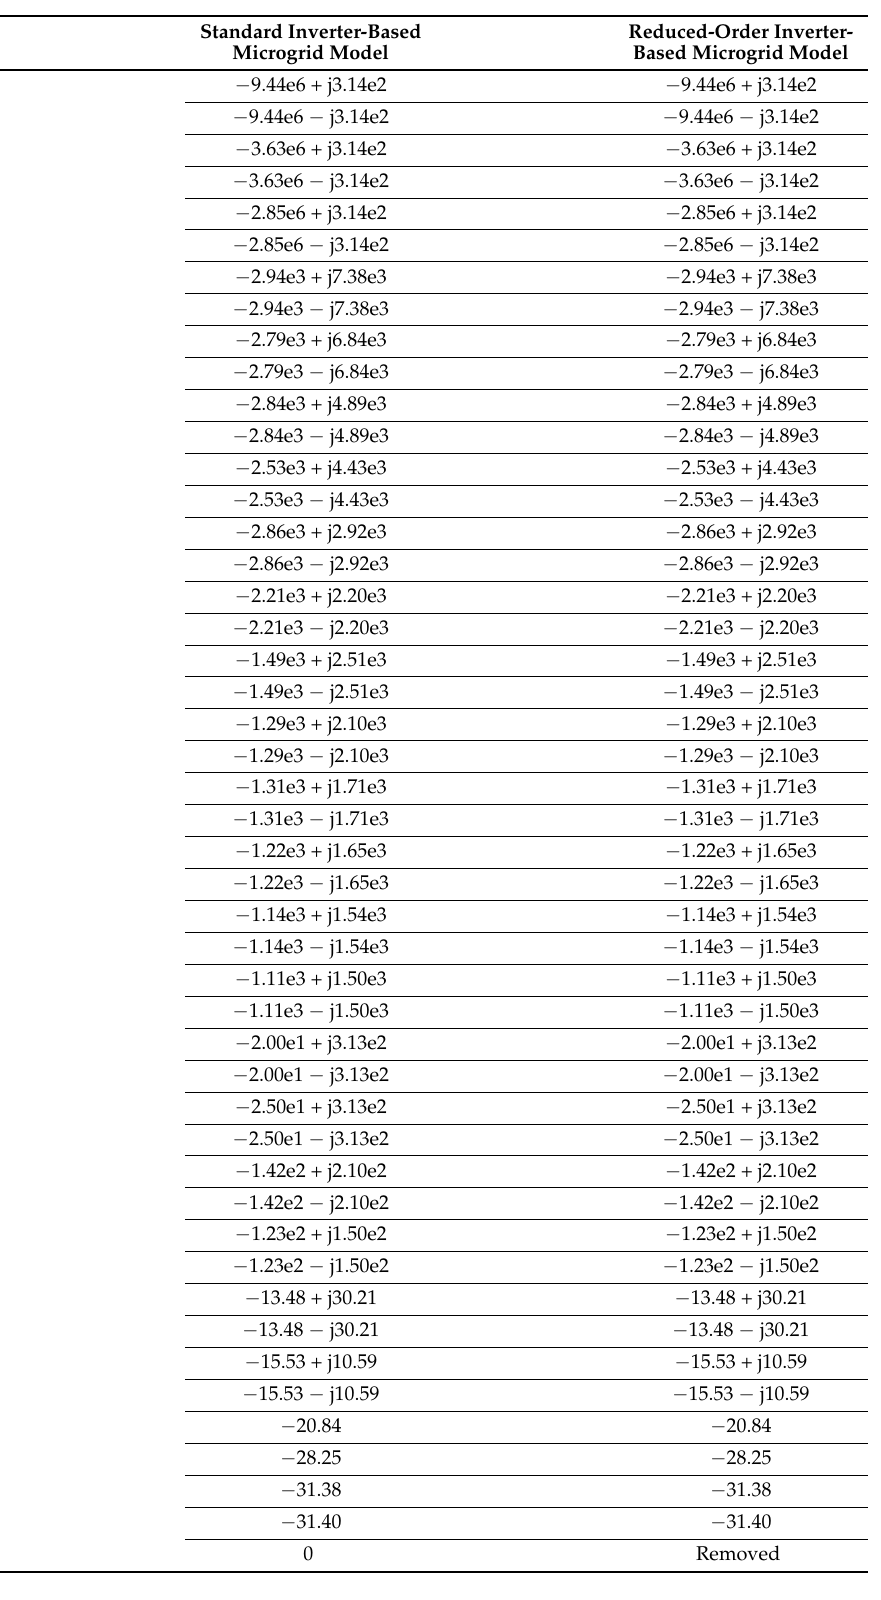
Table 1. Eigenvalues of the microgrid ( A